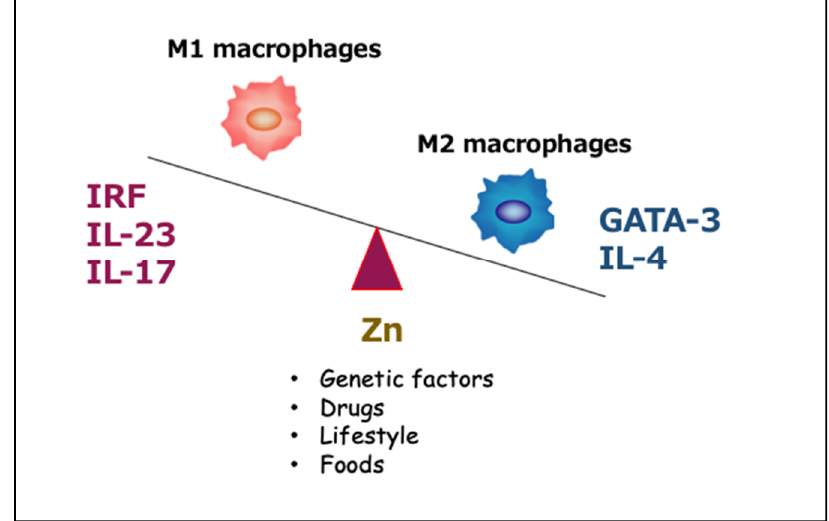
Figure 5. Zinc-mediated regulation of M1/M2 macrophage activation. In zinc-deficient macrophages, interferon-regulatory factor 5 (IRF5) translocates into the nucleus and induces IL-23p19 expression, thereby promoting Th17 differentiation from naïve T cells. Zinc deficiency-induced aggravation of inflammation is associated with a loss of GATA-3 and IL-4 expression and anti-inflammatory M2 macrophages.